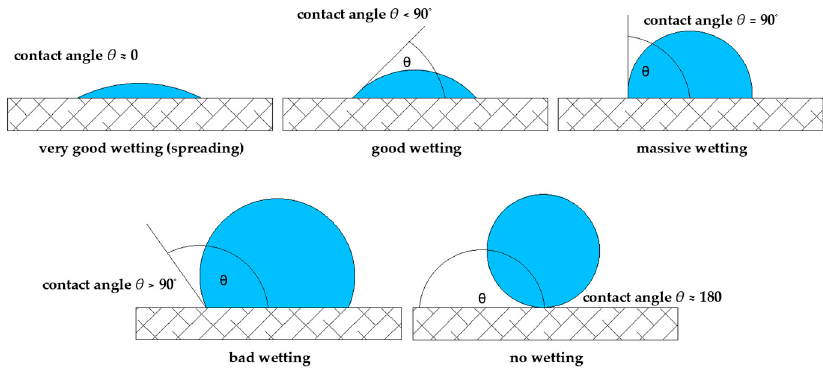
Figure 2. Overview of contact angles as a function of the wetting behavior [52].